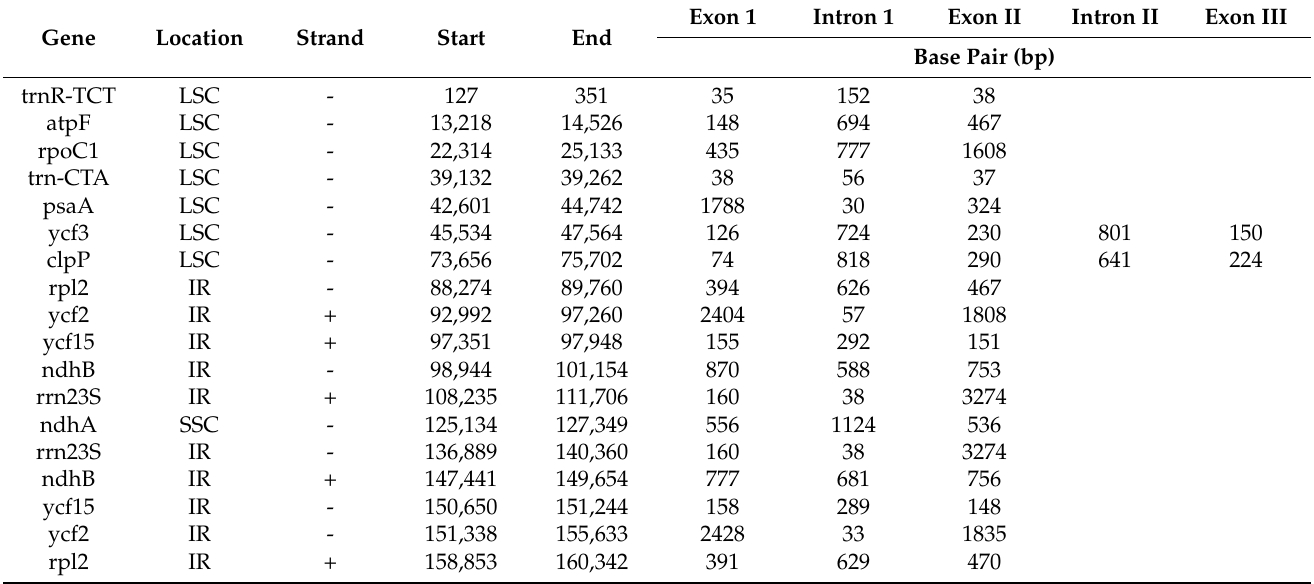
Table 4. Intron containing genes obtained from CPGAVAS analysis of the P. vera chloroplast